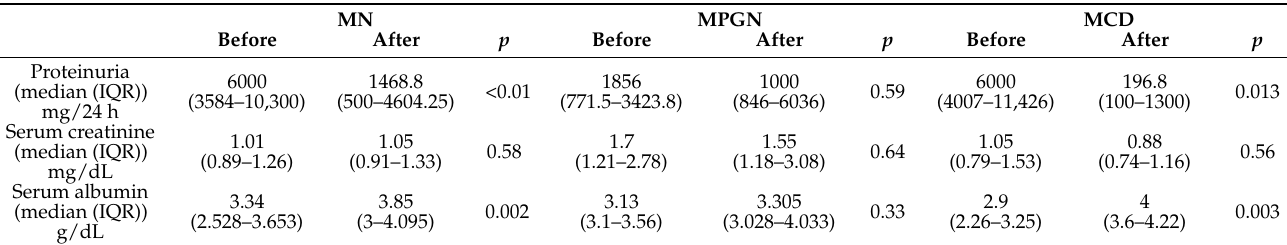
Table 2. Proteinuria, serum creatinine, and serum albumin values before and after rituximab treatment for the three main types of nephropathies. MN MPGN MCD